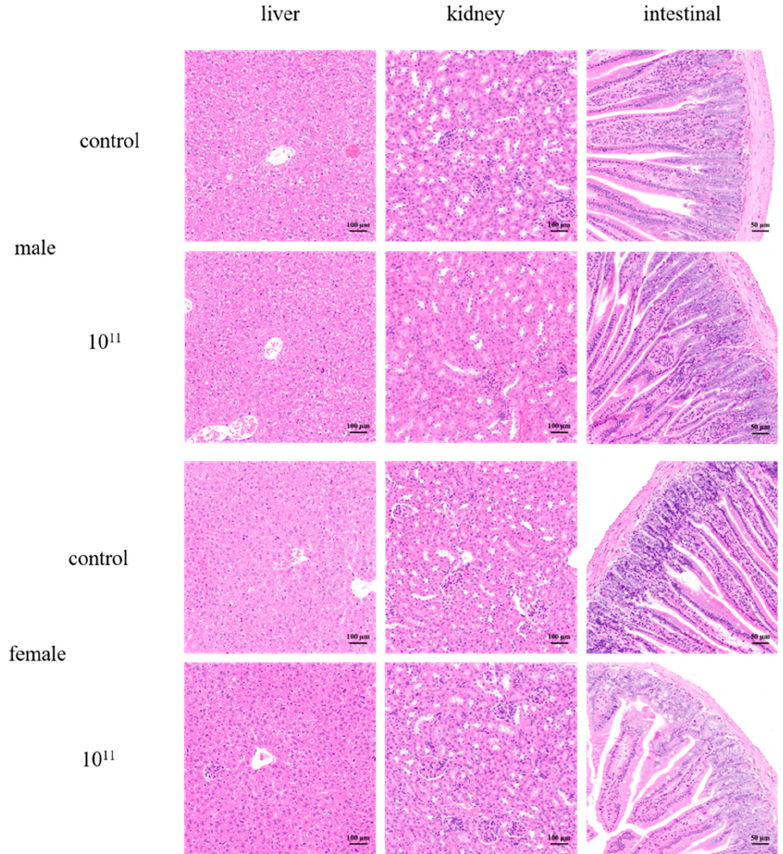
Figure 3. Light micrographs of the sections of the liver, kidney, and intestine of control mice, and mice have given a high concentration of 10 11 CFU/mL of L. plantarum WYH . (×200). Table 3. Hematological parameters in mice for acute oral toxicity.